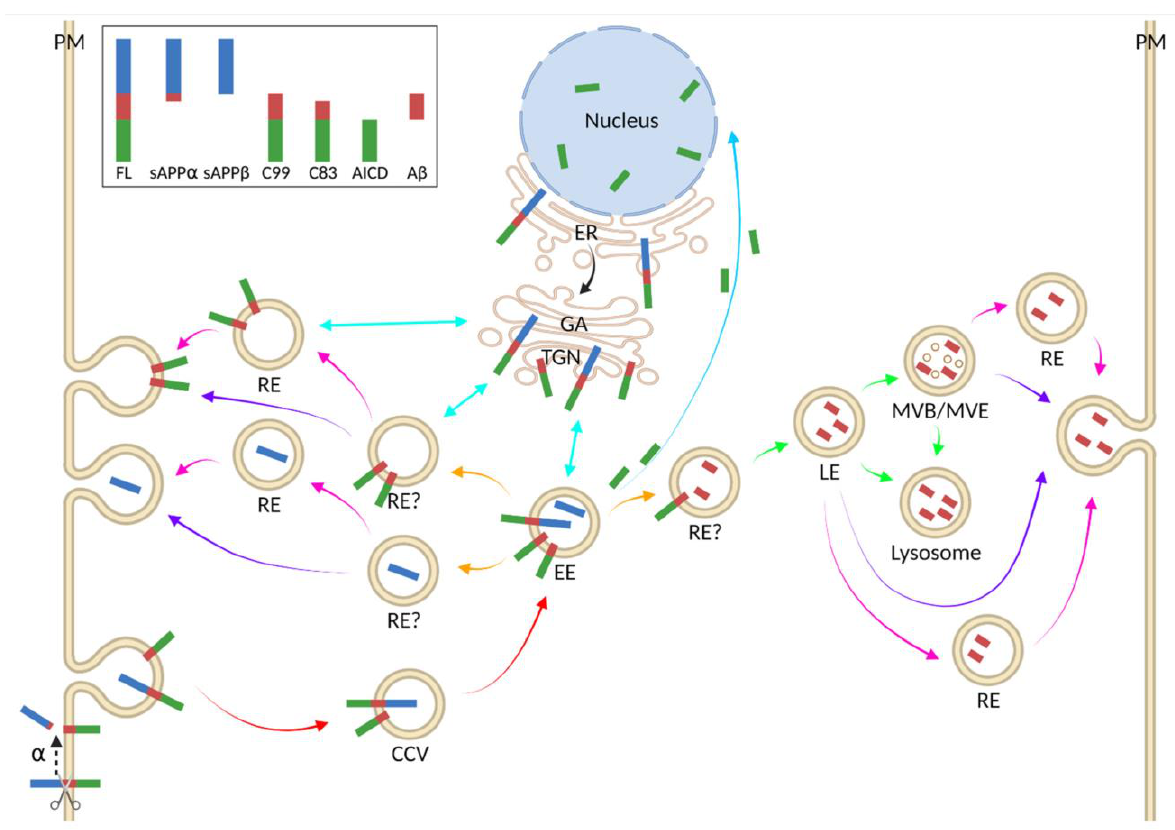
Figure 2. Distribution of APP in neurons. APP traffics along secretory, endocytic and recycling routes and its cleavages occur at multiple sites. ER is short for endoplasmic reticulum, GA is short for Golgi apparatus, TGN is short for trans -Golgi network, EE is short for early endosome, LE is short for late endosome, RE is short for recycling endosome, MVB is short for multivesicular body, MVE is short for multivesicular endosome, CCV is short for clathrin-coated vesicle. Blue, green and red bars represent full-length APP (FL); blue (and red) bars represent N-terminal fragments (NTFs; including sAPP ⍺ and sAPPβ) ; red and green bars represent C-terminal fragments (CTFs; including C83, C99 and AICD); and red bars represent Aβs. The black arrow indicates the trafficking of APP from the ER to the GA/TGN; turquoise arrows indicate the trafficking of APP between endocytic compartments and the TGN; red arrows indicate the endocytosis of APP from the PM (the scissor indicates the major ⍺ -secretase cleavage site of APP, where membrane-bound full-length APP becomes C83); magenta and purple arrows indicate the indirect (via REs) and direct recycling of APP towards the PM and secretion into the extracellular space; green arrows indicate the trafficking of APP within the endocytic pathway towards the lysosome; orange arrows indicate the potential sorting of APP in EEs; and the plain blue arrow indicates the trafficking of AICD towards the nucleus. This figure was produced with BioRender.com.